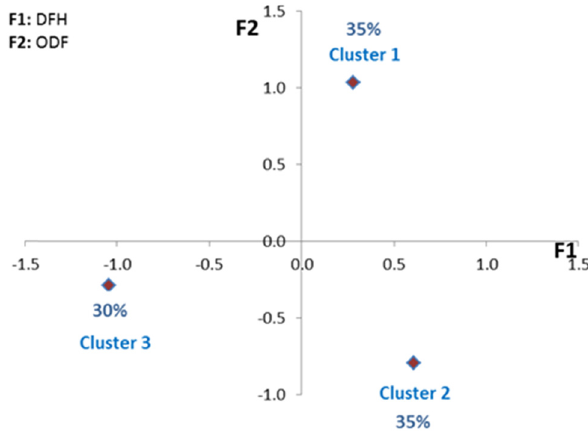
Figure 4: Final cluster location in relation to both factors.